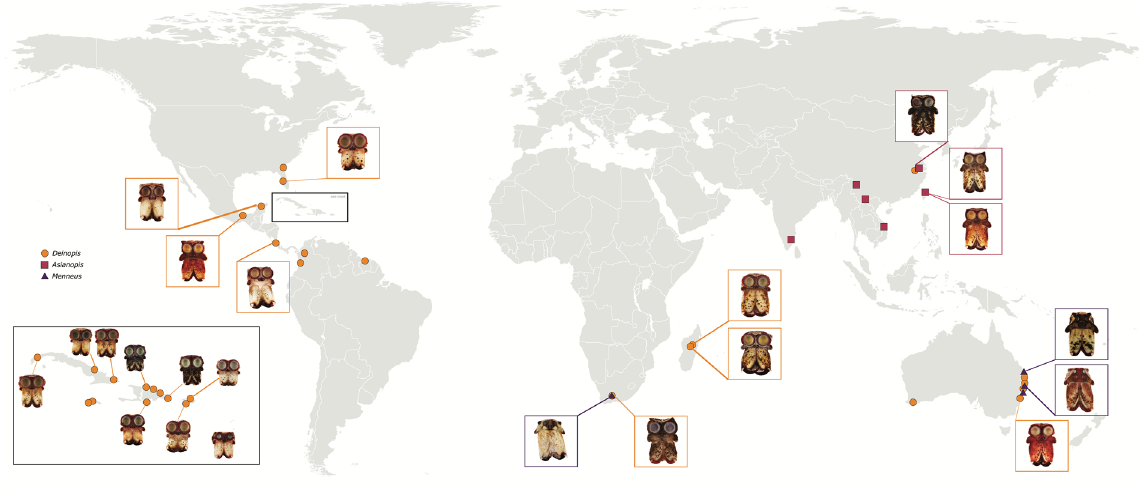
Figure 2. Sampling map of deinopids. Localities colored by current taxonomic genus. Map was created using the base map form Wikimedia Commons (https:// commo ns. wikim edia. org/ wiki/ File: Blank Map- World. svg) Map: Lisa